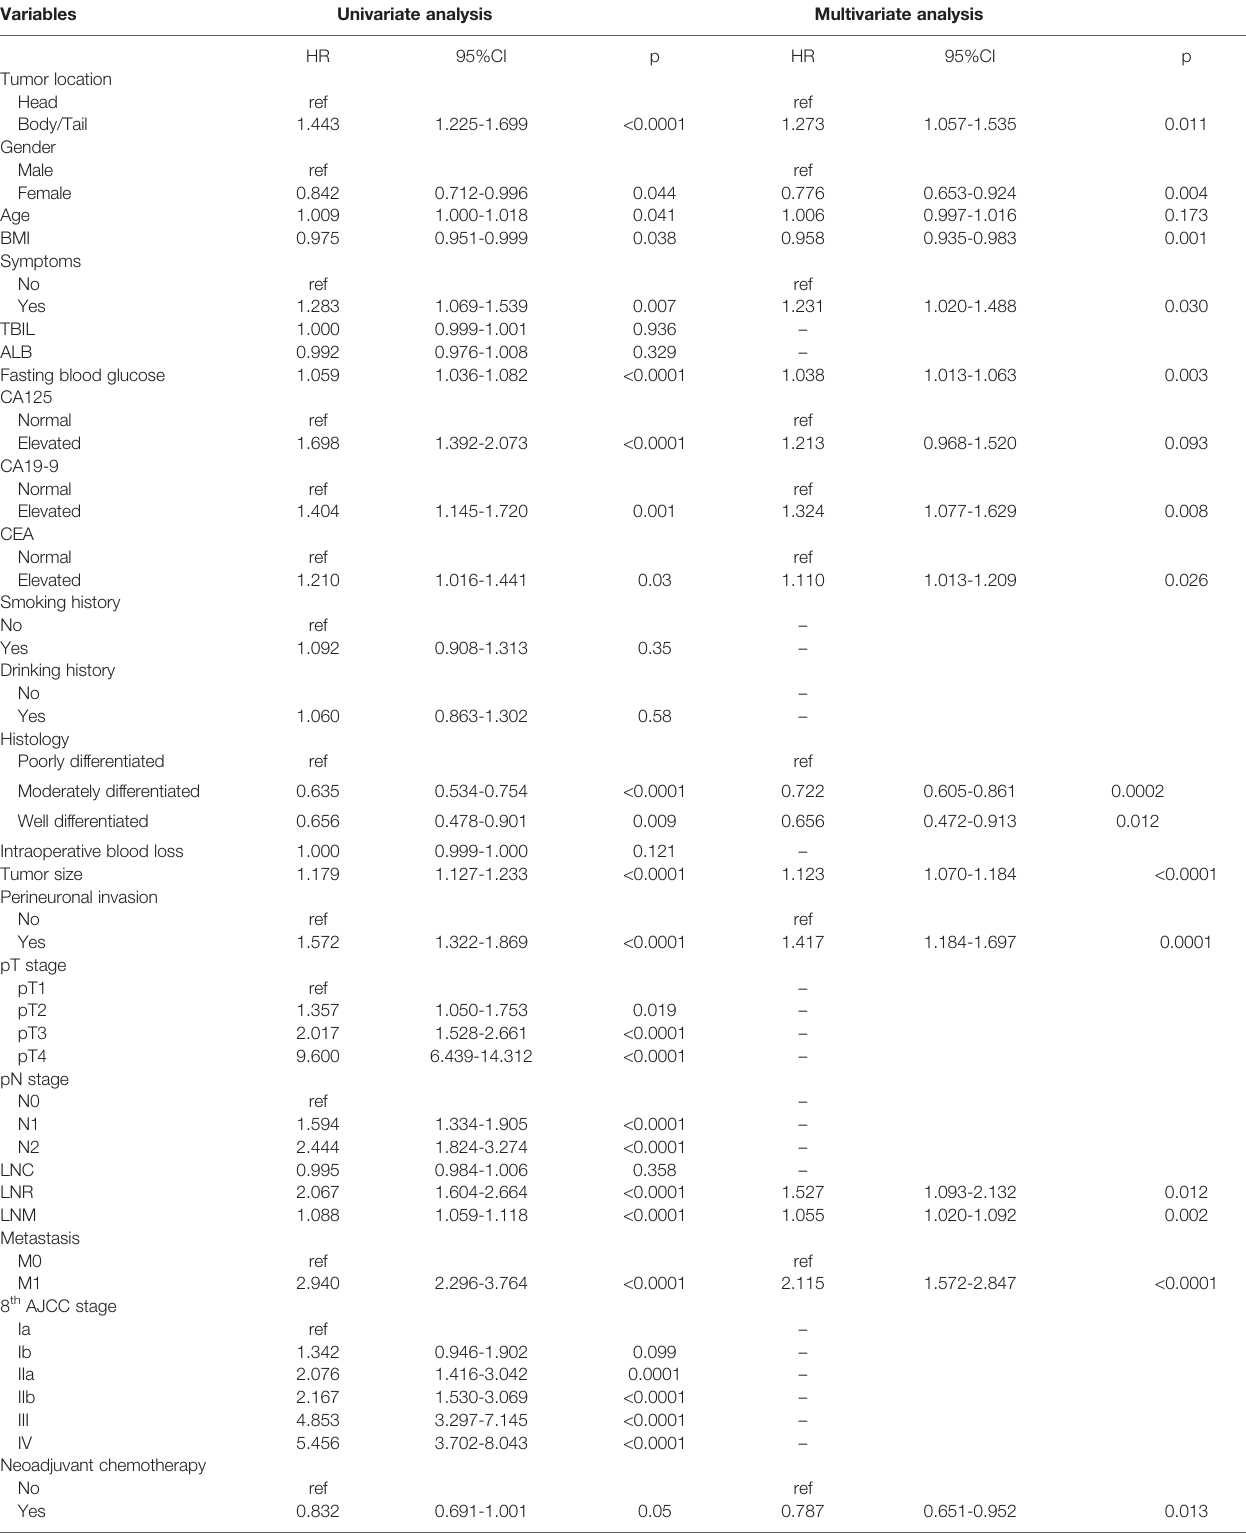
TABLE 2 | Univariate and multivariate Cox regression analyses of prognostic factors in PDAC patients with curative-intent surgical